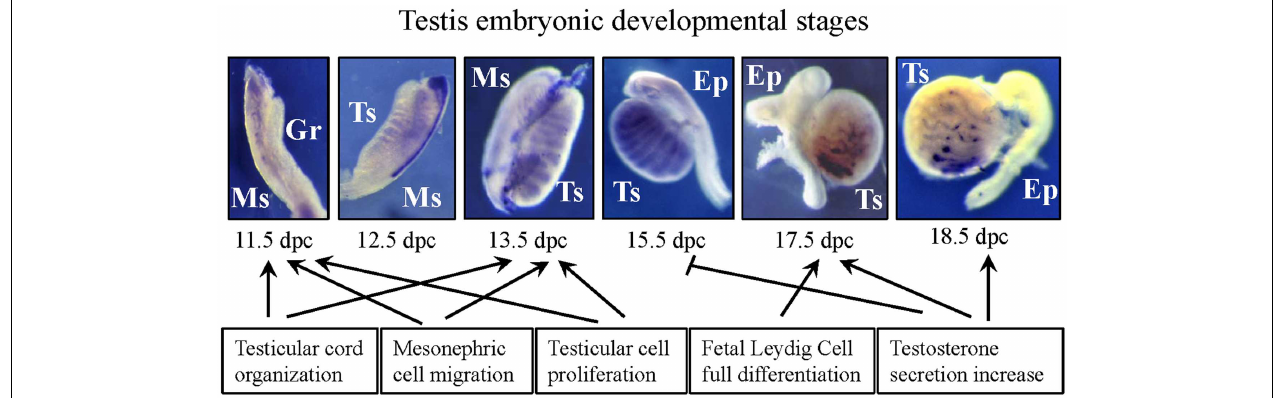
FIGURE 1 | Picture summarizing the main effects exerted by HGF during embryonic testis development . Purple signal in the developing urogenital ridges at different pre-natal stages indicates c-Met mRNA expression. Gr, genital ridge;Ts, testis; Ms, mesonephros; Ep,